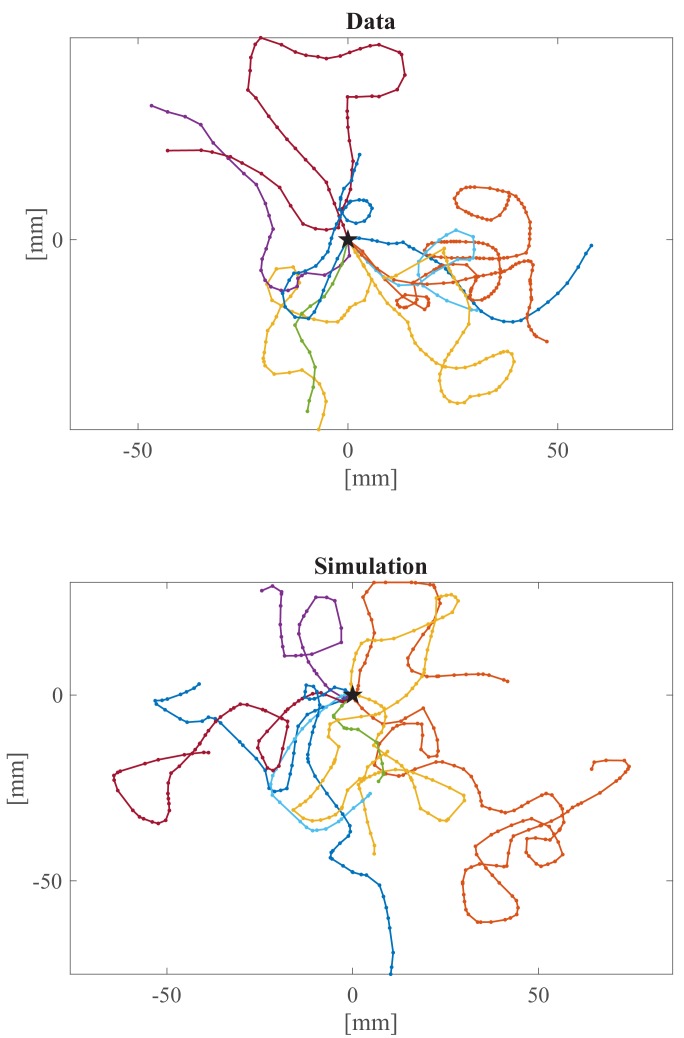
Comparison of experimental and simulated trajectories.Examples of experimental and simulated (neuronal model) trajectories. The black star indicates the initial position of each trajectory. Each dot corresponds to one swim bout.